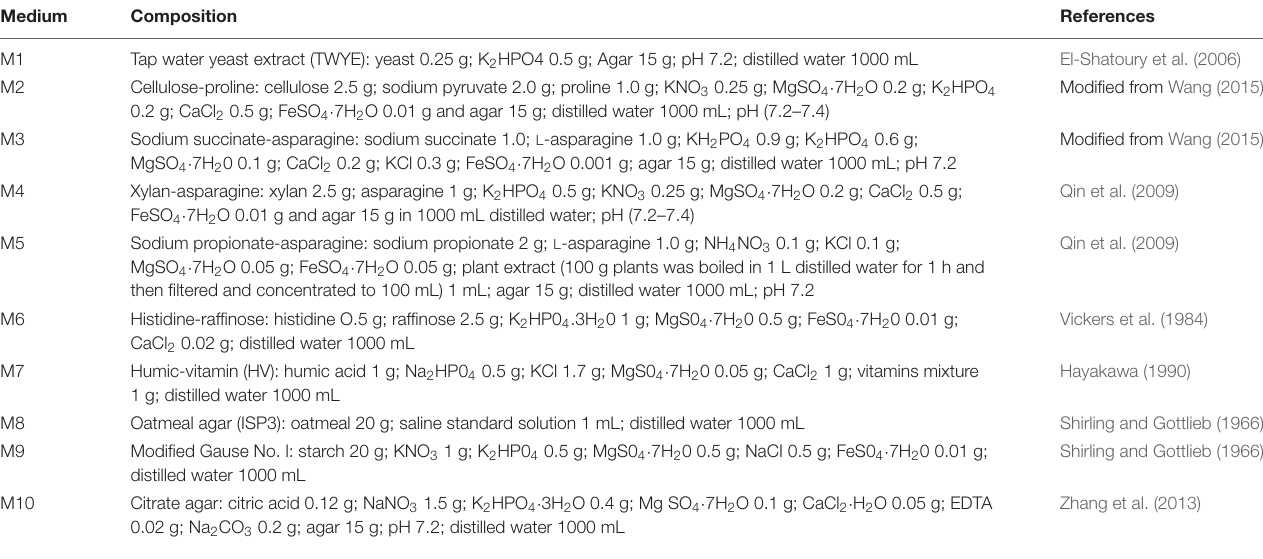
TABLE 1 | Composition of the media used for the isolation of endophytic actinomycetes from medicinal plants.